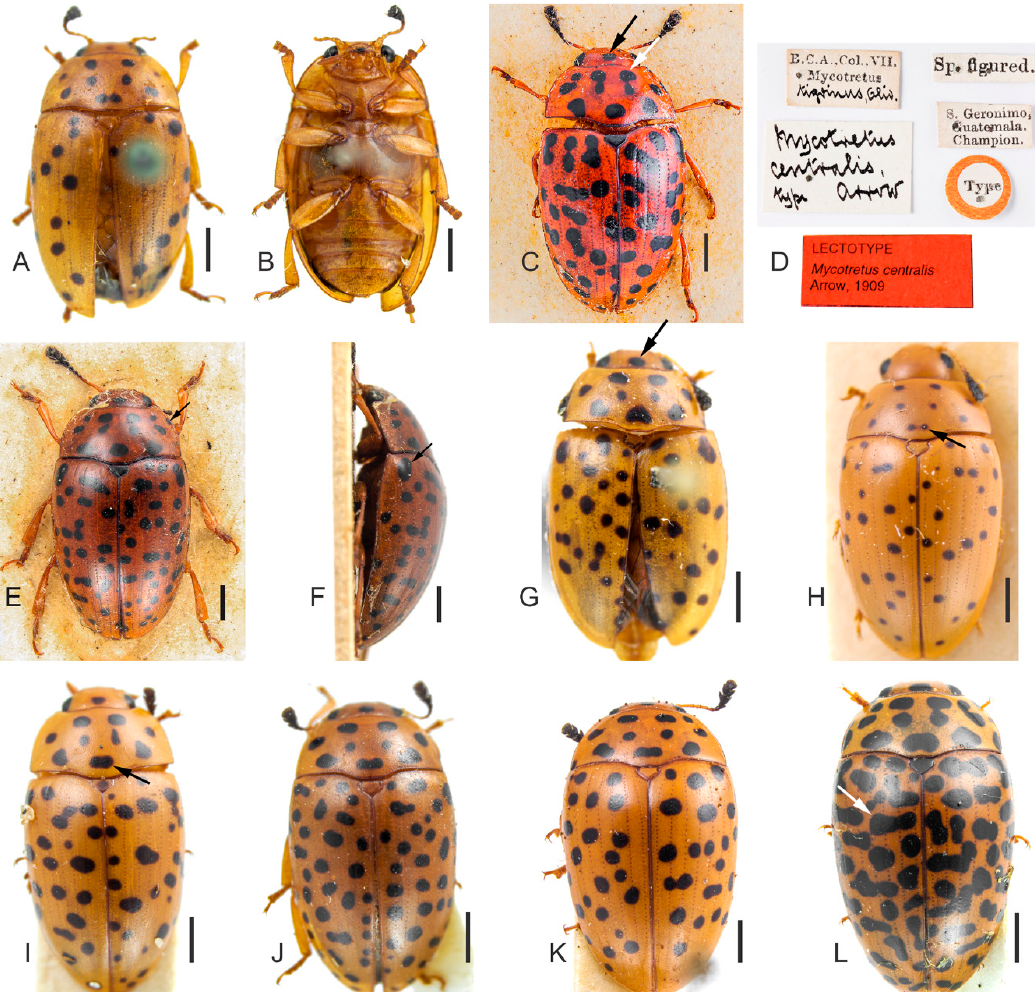
Figure 4. ( A – L ) Specimens of Mycotretus centralis Arrow, 1909 from different localities: ( A – B ) male, dorsal and ventral view, respectively (Carazinho, RS, Brazil). ( C – D ) Lectotype (San Jerónimo, Guatemala): ( C ) dorsal view, black arrow showing the major black spot on the disc of head, white arrow showing the two anterior medial spots. ( D ) Labels. ( E – F ) A male paralectotype (San Jerónimo, Guatemala): ( E ) dorsal view, arrow showing a spot connected to the lateral pronotal edge, ( F ) lateral view, arrow showing a spot on the humeral angle. ( G – L ) Specimens in dorsal view: ( G ) male, arrow showing the major black spot on the disc of head (Campo Bom, RS, Brazil); ( H ) female, arrow showing the medial spots not completely fused (Pitanga, PR, Brazil); ( I ) female, arrow showing the medial spot on the pronotal base (Nova Teut ô nia, SC, Brazil); ( J ) female (Pira í , Repr ê sa Rio Grande, RJ, Brazil); ( K ) female (Pira í , Repr ê sa Rio Grande, RJ, Brazil); ( L ) female, arrow showing an elongated spot on the disc of elytra (Pedra Azul, MG, Brazil). Scale bars: A – C , E – L = 1 mm. Redescription. Length (in mm) = 5.07–6.89 (6.13 ± 0.60, n = 9). Body elongate, slightly oval, widest at anterior third of elytra, TL/EW = 1.60–1.77 (1.69 ± 0.06), glabrous and glossy, dorsal and ventral coloration homogeneously yellowish or reddish-brown (Figure 4A–L). Mouthparts of same background color as body, mandible apices blackish and with two teeth; mentum plate pentagonal, with strongly sclerotized margin; antennae yellowish or reddish-brown, last antennomeres blackish. Scutellar shield yellowish, reddish-brown or blackish, glabrous and bearing few punctures. Dorsal coloration: head with one large and subcircular black spot on disc, Figure 4C,G, arrow (specimens from Guatemala with one or two black spots, small, free and close to major spot on disc); pronotum with black, free and subcircular spots (Figure 4) symmetrically and transversely arranged, as